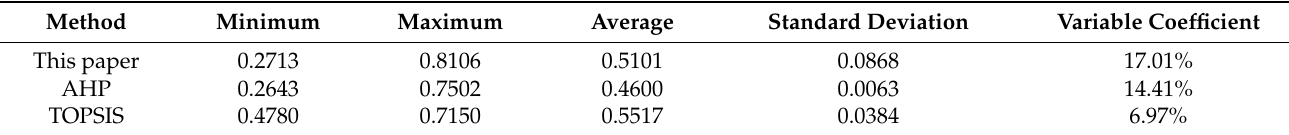
Table 6. Statistics of evaluation results of three methods under target layer T1.